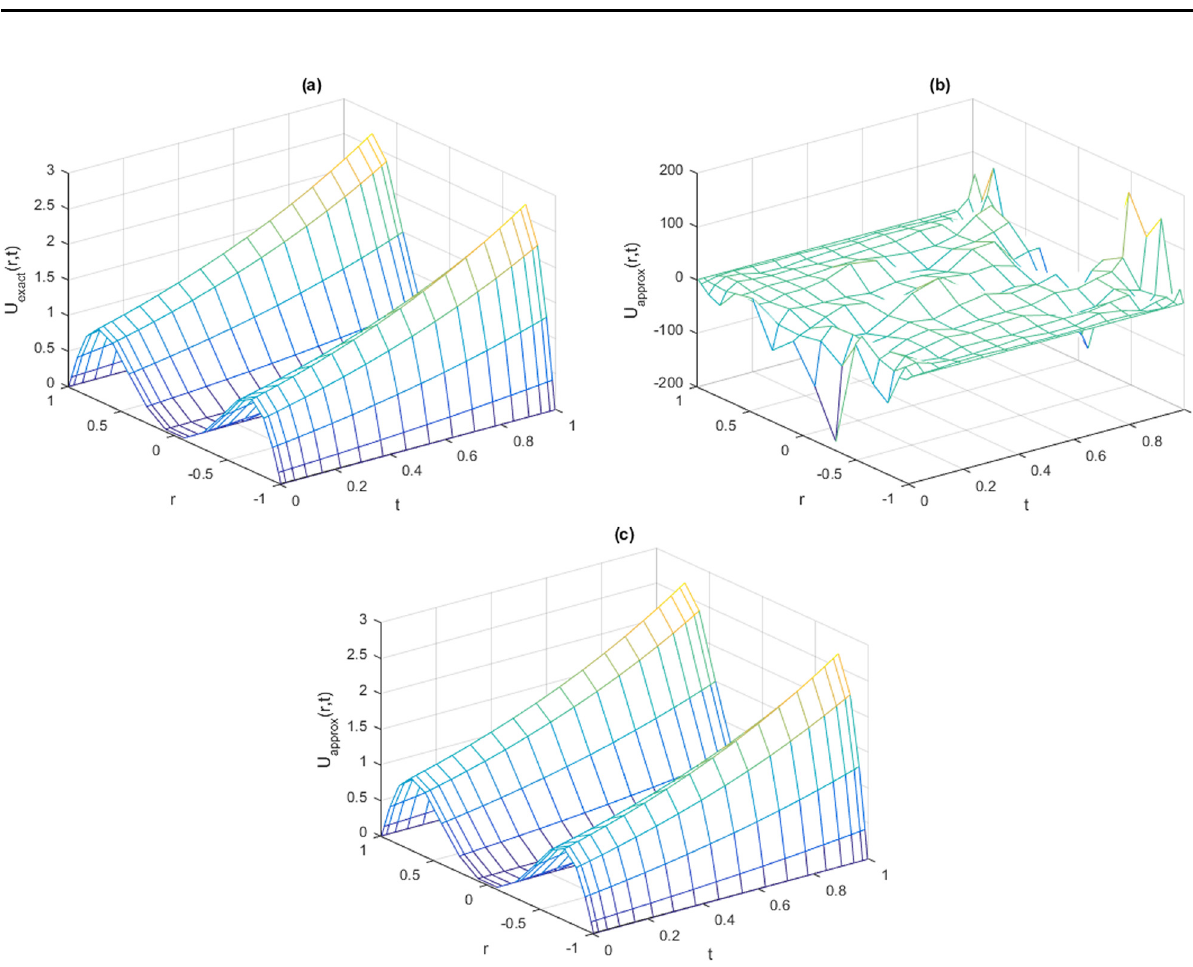
Figure 1: The observations of Example 4.1 for N M 20 =